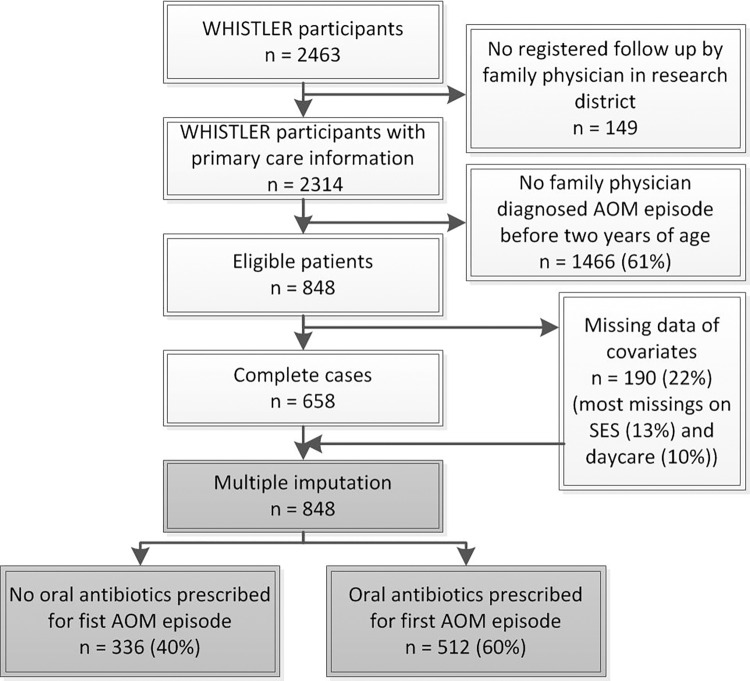
Flow chart of study populationAbbreviations: AOM, acute otitis media. SES, socio-economic status.